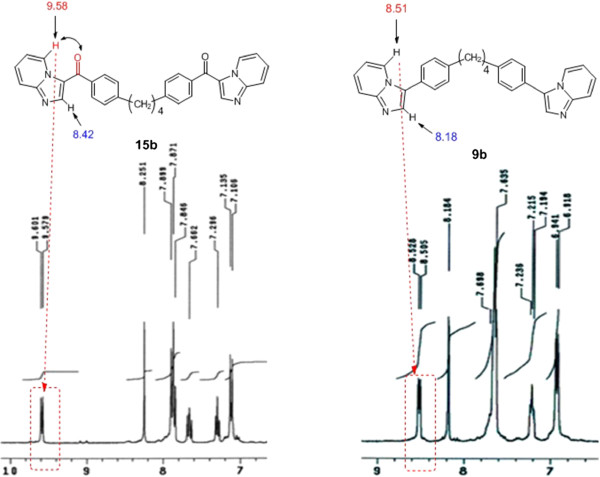
Aromatic region of the 1H NMR spectra of the p-isomers of 15b and 9b.